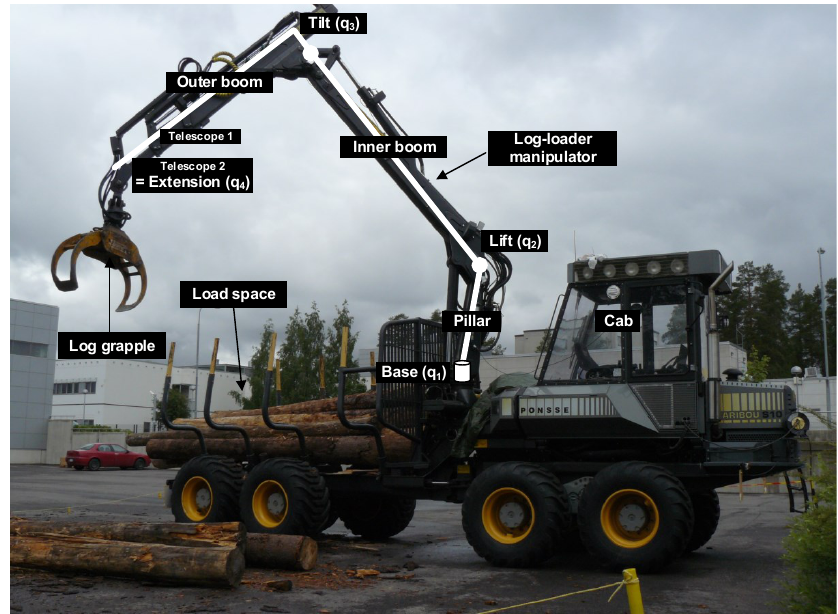
Figure 1. Kinematically redundant K70M hydraulic manipulator on Ponsse Caribou S10 forwarder, with log grapple end-effector.